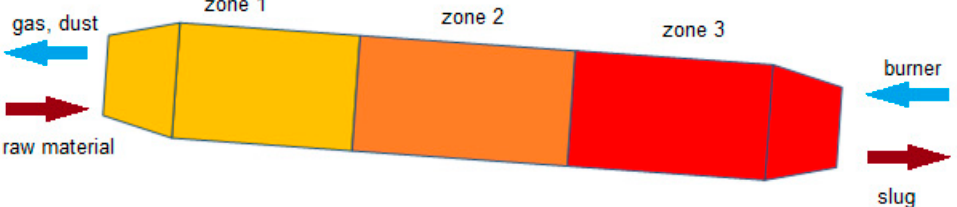
Figure 2. Scheme of the rotary kiln divided into zones [12]. A detailed description of the reactions in each zone is provided below.